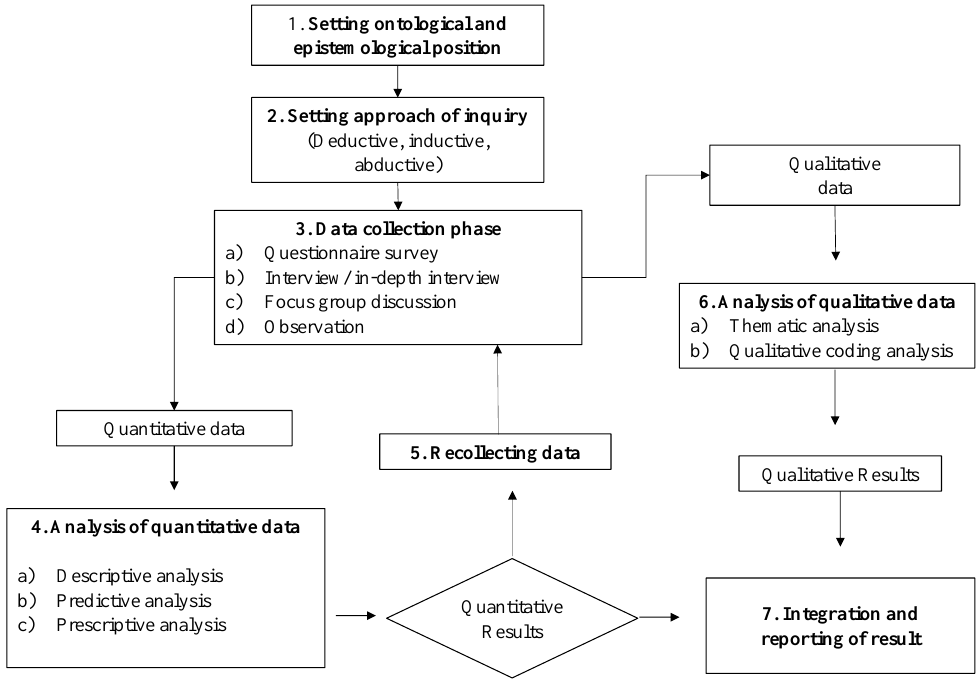
Figure 1: Workflow of Explanatory Sequential Design of MMR (developed by author based on literature) Recollecting